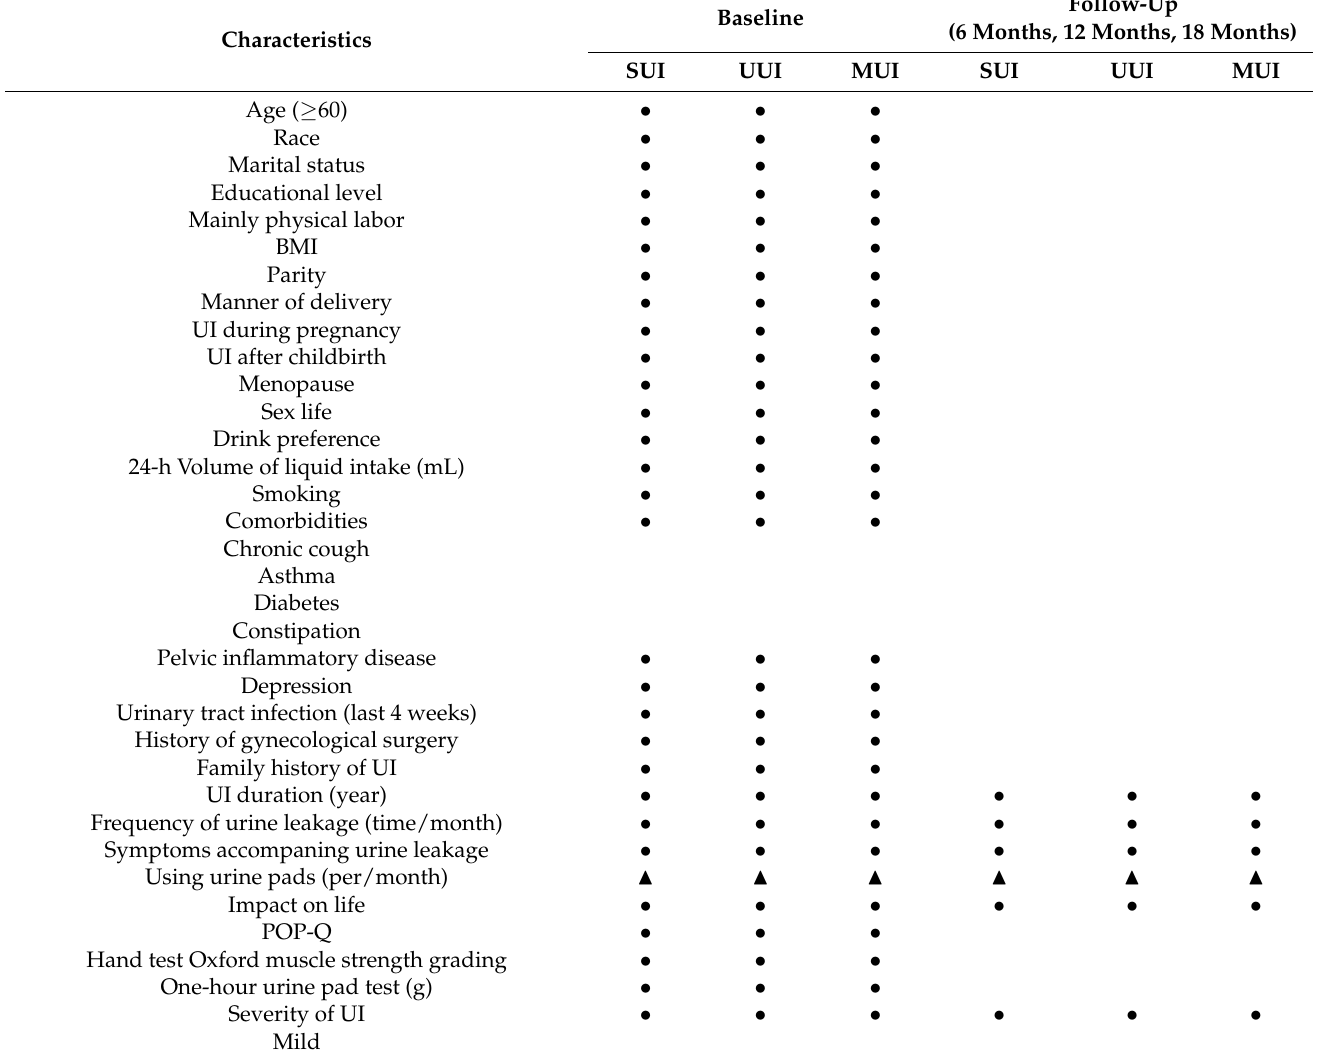
Table 2. Participant baseline screening, assessment, and follow-up